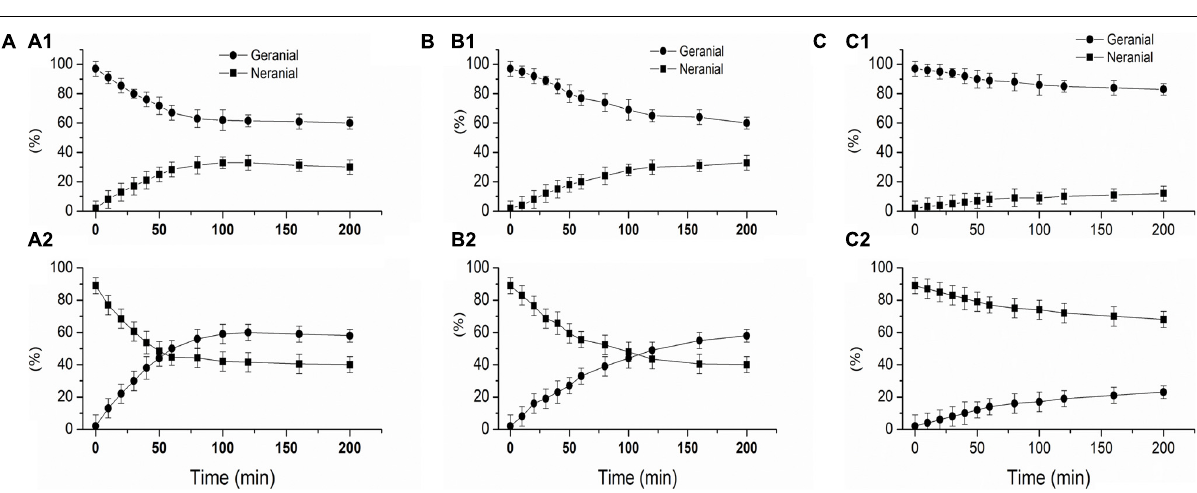
FIGURE 2 | protein-catalyzed isomerization of geranial and neral, SPI 1%, 20 mmol/L potassium phosphate buffer (pH 7.0), Geranial and neral are expressed as a percentage of total citral. (A) L-SPI, (B) N-SPI, (C)